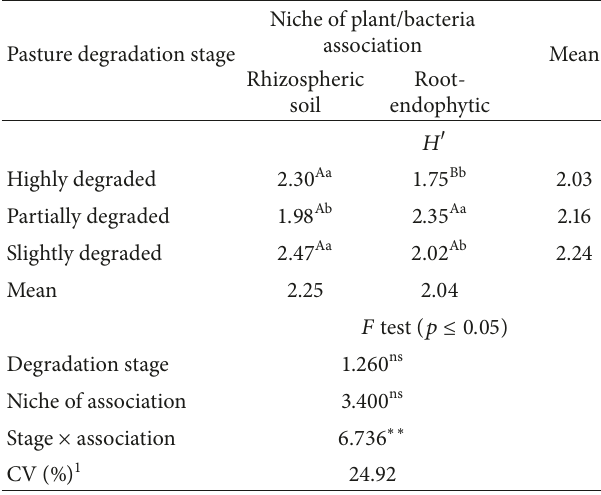
Table 4: Shannon-Weaver diversity index of the cultivated dia- zotrophic bacterial community in different niches of plant/bacteria association in B. decumbens Stapf. pasture in different stages of